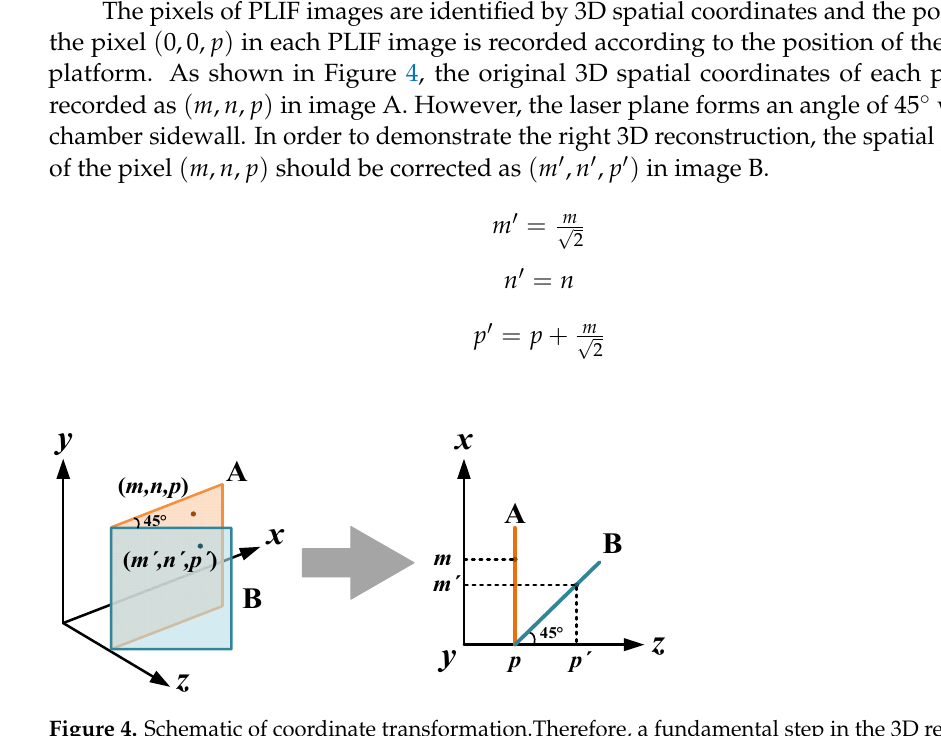
Figure 4. Schematic of coordinate transformation.Therefore, a fundamental step in the 3D reconstruc- tion is to realize the spatial coordinate transformation from image A to image